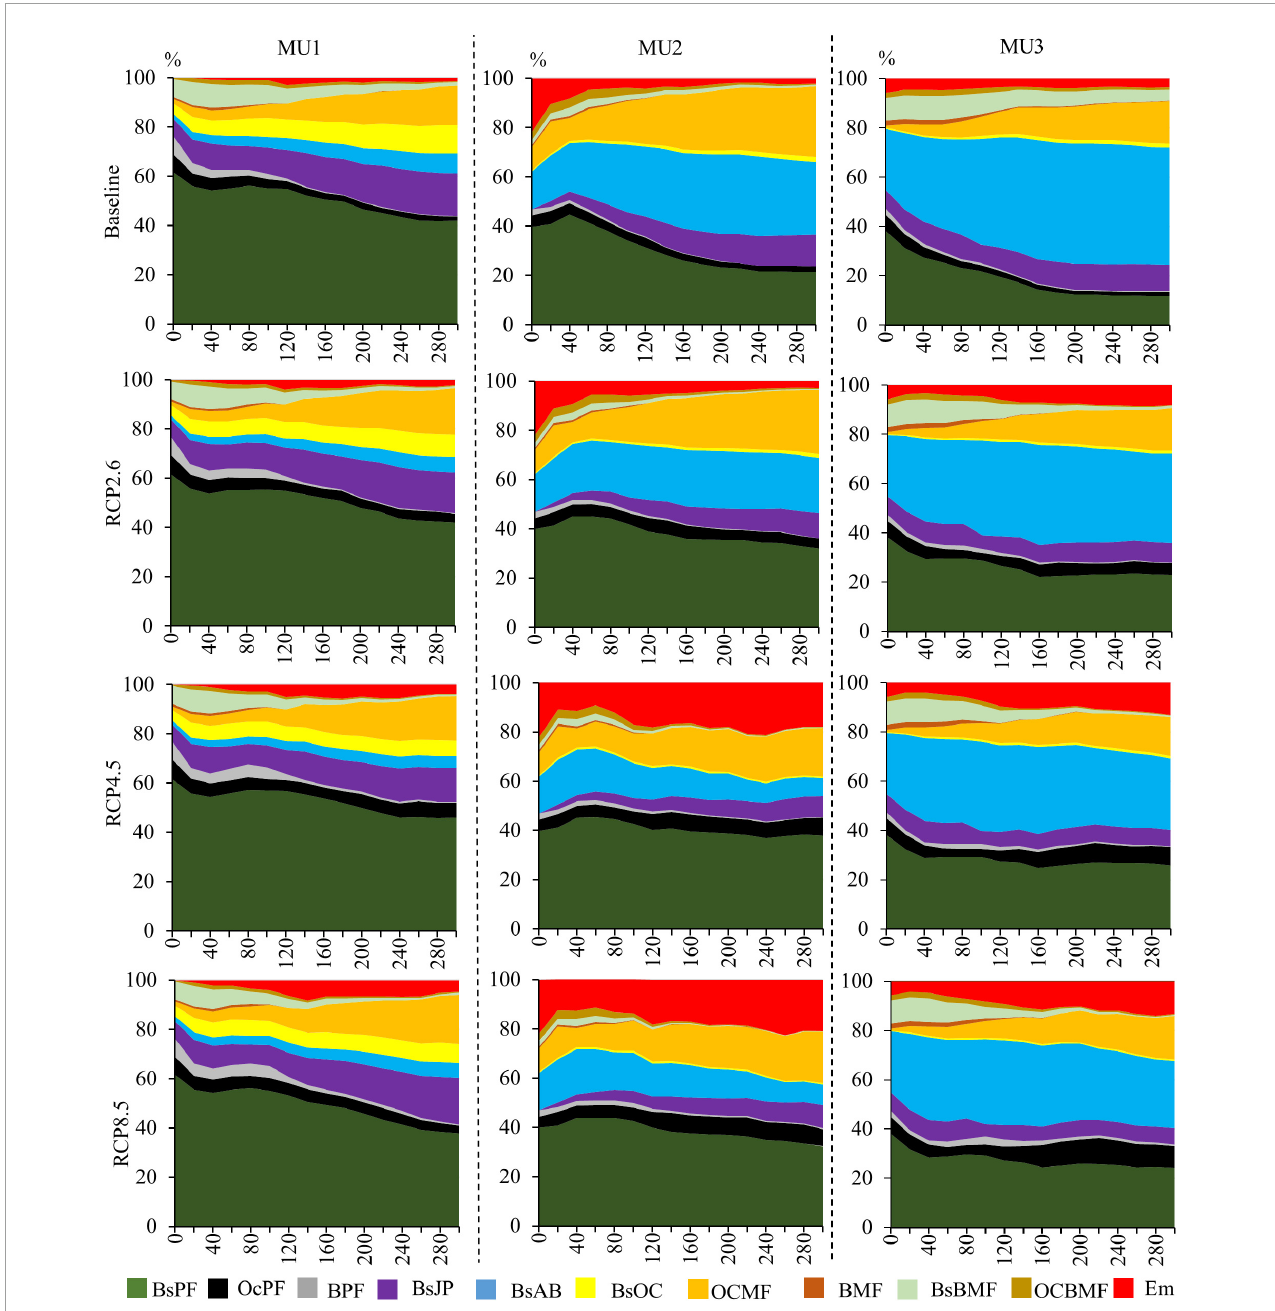
FIGURE9 The occupancy area of each forest type (%) in the three MU under the four climate scenarios, where we assumed that broadleaves will not disperse across all the landscape because of soil limitation (BsPF, black spruce pure forests; OcPF, other coniferous pure forests; BPF, broadleaves pure forests; BsJP, black spruce and jack pine; BsAB, black spruce and balsam fir; BsOC, black spruce and other coniferous; OCMF, other coniferous mixed forests; BMF, broadleaves mixed forests; BsBMF, black spruce and broadleaves mixed forests; OCBMF, other coniferous and broadleaves mixed forests; Em, empty land which presents open forest